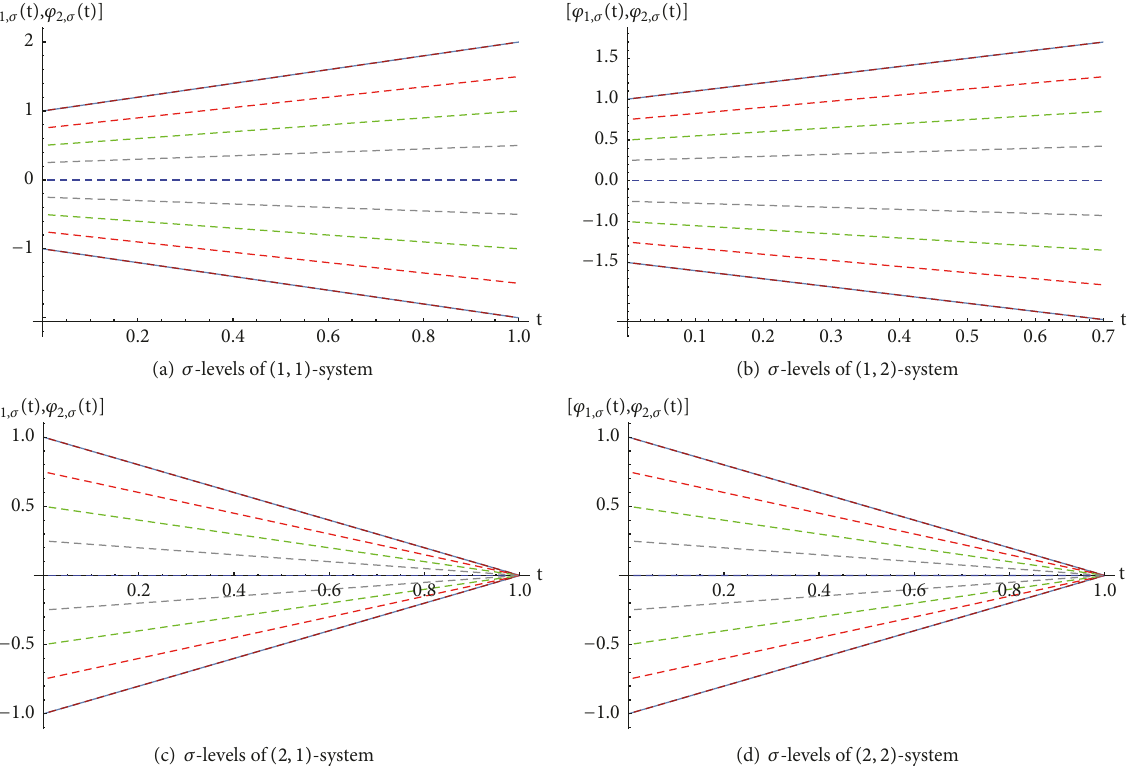
Figure 2: Plots of exact and RPS-approximation at 𝛾 = 2 with different values of 𝜎 -levels, 𝜎 ∈ {0,0.25, 0.5, 0.75, 1} (--- Exact, ⋅⋅⋅ RPS-